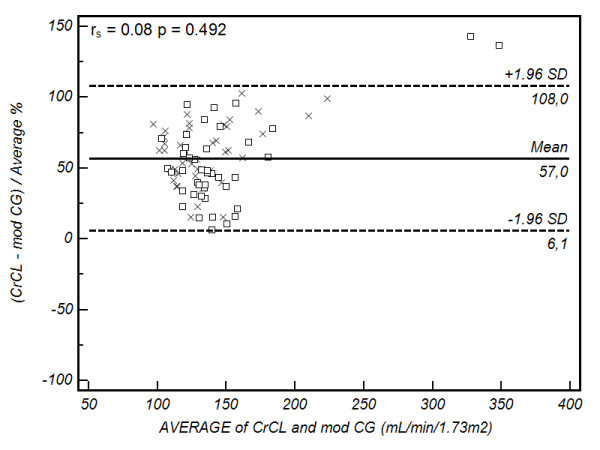
Bland-Altman plot of CLCR vs modified Cockcroft Gault formula. Comparison of the difference between the measured creatinine clearance (CLCR) and modified Cockcroft Gault (modCG) formula (as a percentage) on the y-axis, versus the average value obtained on the x-axis. The solid line represents the bias (mean percentage difference obtained across the range of values), where as the dashed lines are the limits of agreement (+/- 1.96 × standard deviation (SD)). square, Australia cohort; cross, Portugal cohort. The Spearman correlation coefficient (rs) for the percentage difference and average value is provided in the top left hand corner (outliers excluded).